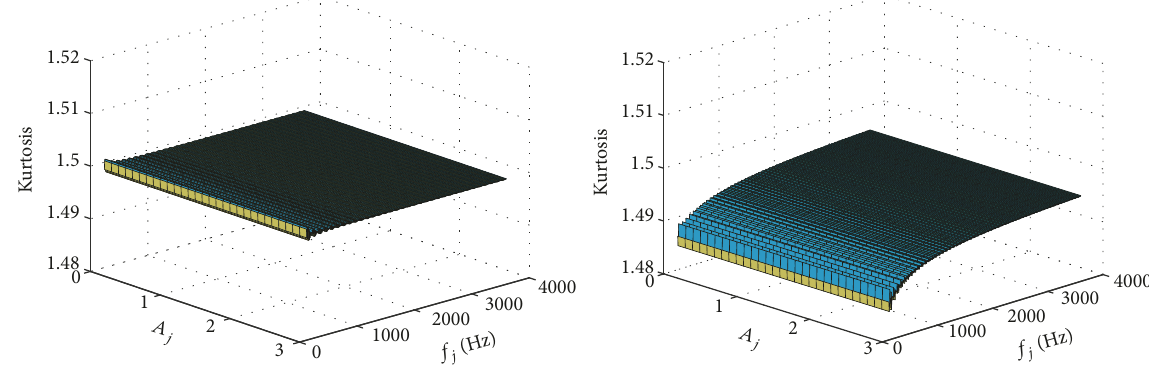
Figure 3: Illustration of kurtosis of noncomposite